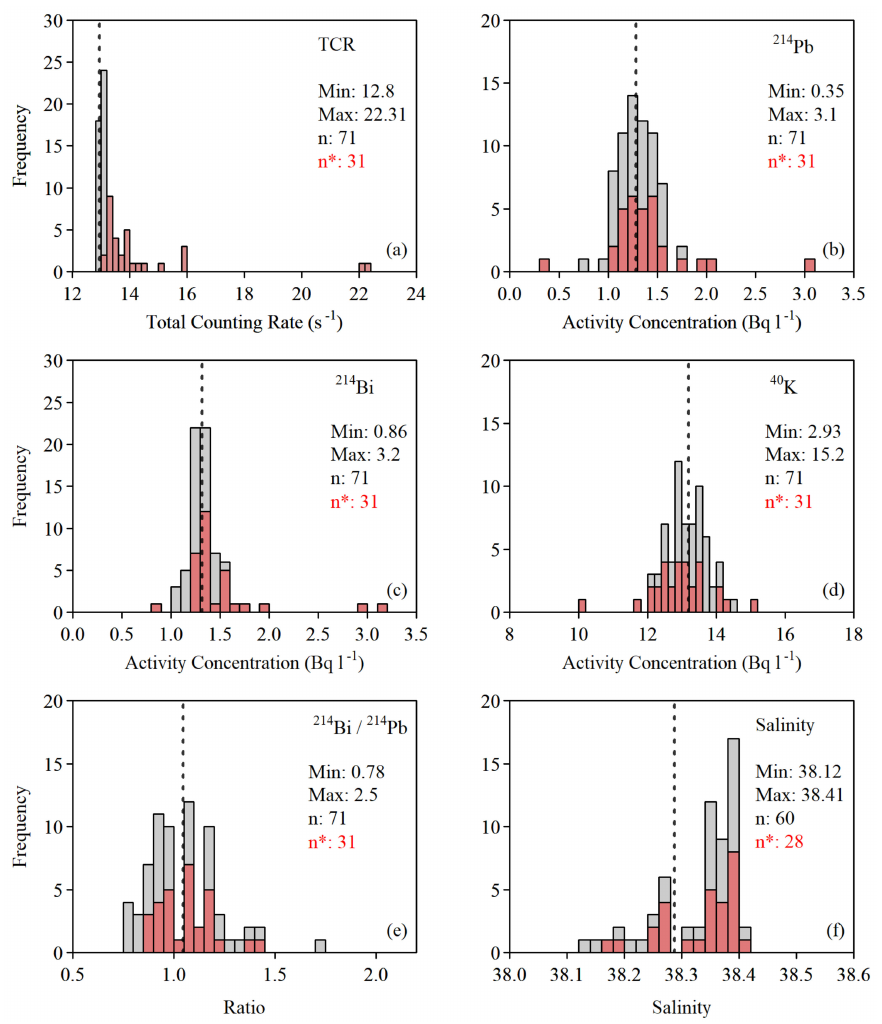
Figure 4. The distribution of TCR values ( a ) radon progenies ( b , c ) and 40 K ( d ) activity concentration, radon progenies ratio ( e ) and salinity ( f ) during rainfall events (n). When the TCR statistical criterion is fulfilled (n*), the corresponded values are presented with red bars. The mean value during dry meteorological periods of each parameter is depicted by a dotted vertical